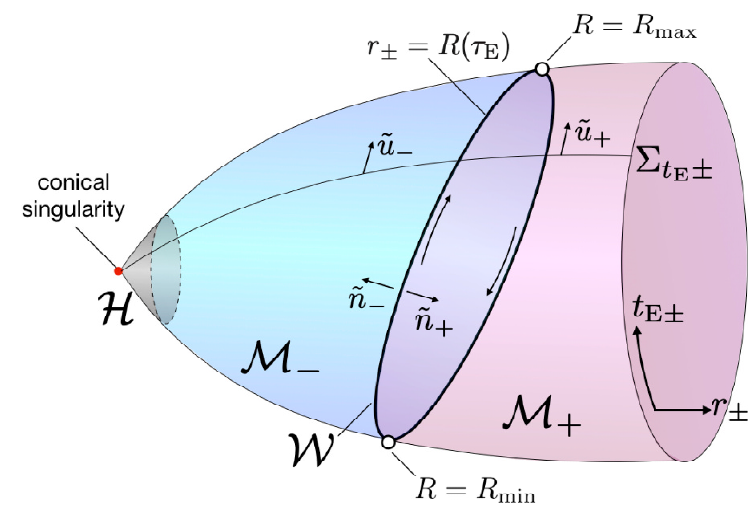
Figure 4 . Schematic picture showing the decomposition of the O (3)-Euclidean manifold in the existence of the thin-wall vacuum bubble and the BH